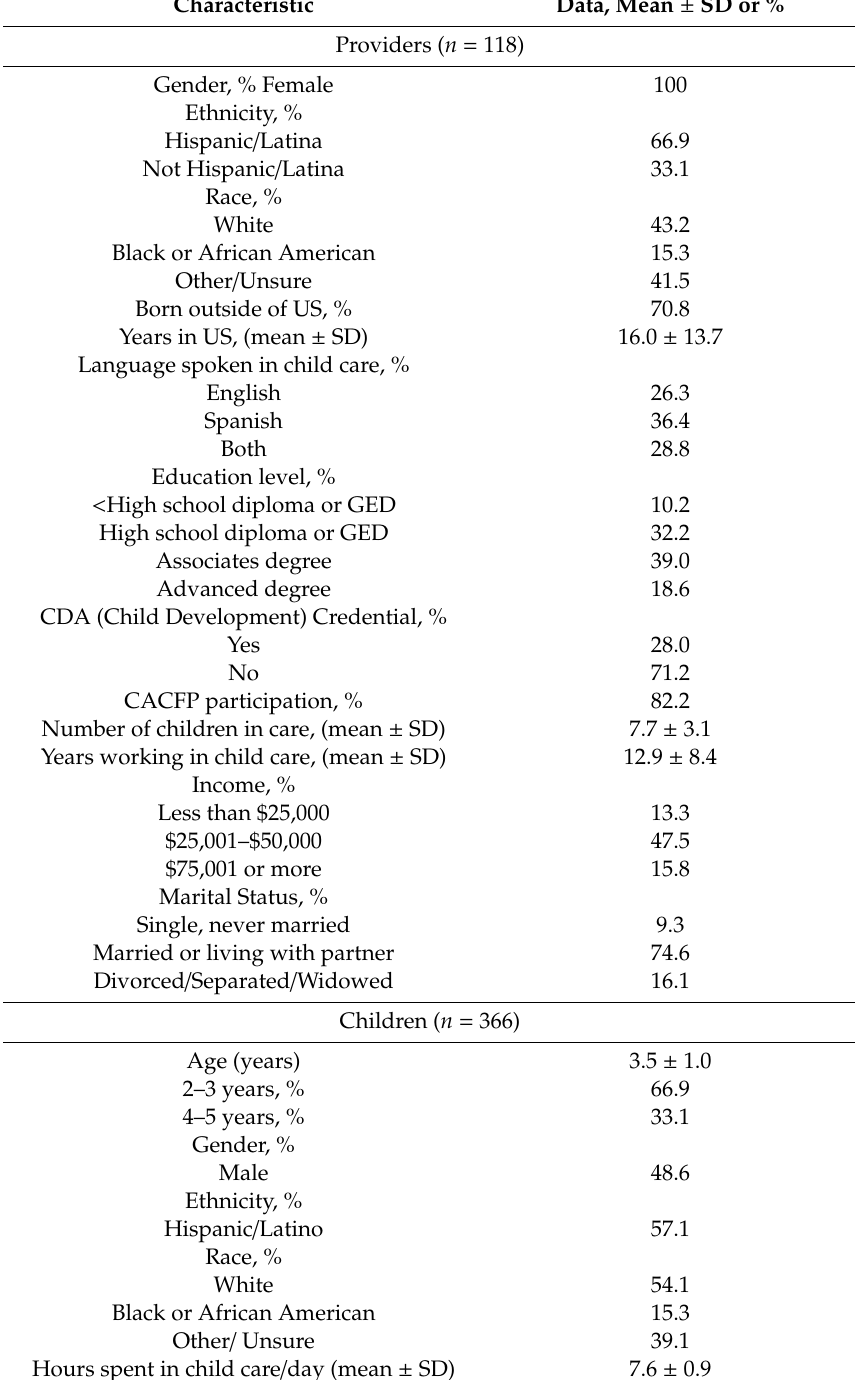
Table 1. Descriptive data of Providers and